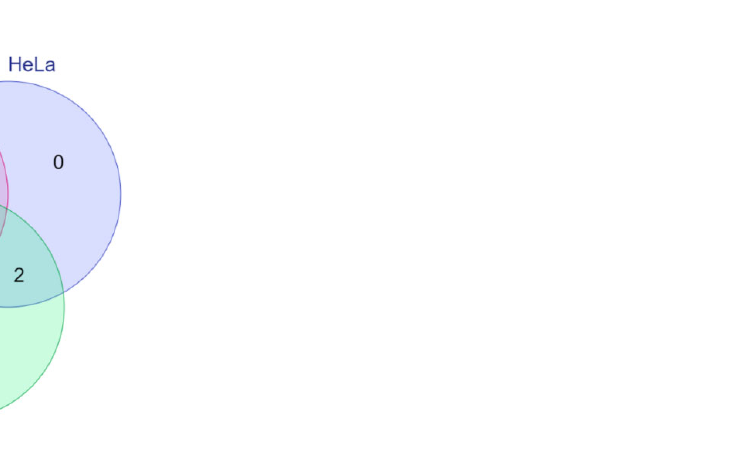
Figure 4. Overlapping hits of miRNAs from the “ULA-norm-Ad” group between SiHa, HeLa, and FK18B cells. Table 1. Overlapping miRNAs reducing growth in SiHa, HeLa and/or FK18B cells.